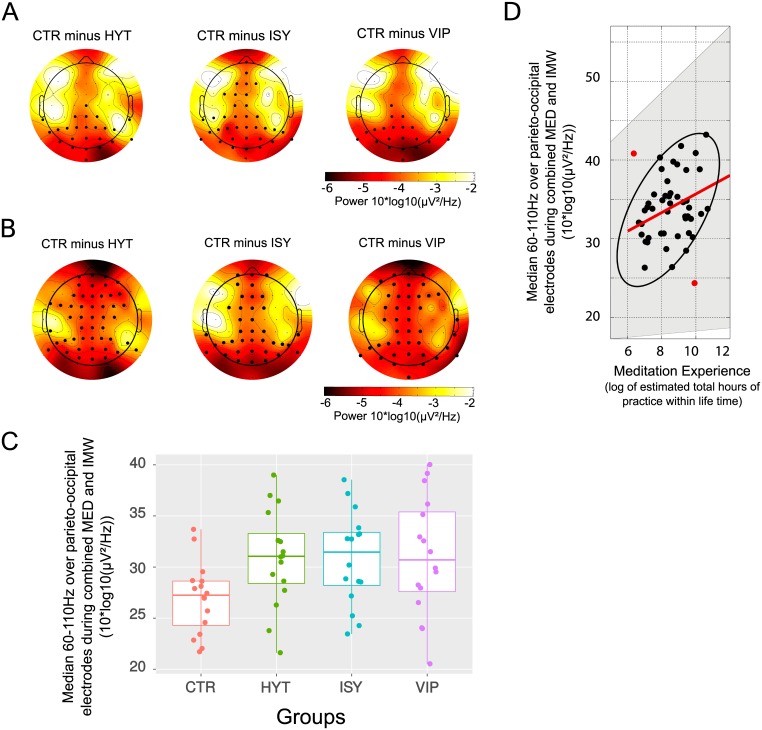
A. Spectral differences in the 60–110 Hz range between the control group and each of the meditator groups with MED and IMW conditions combined. A black dot at a given electrode site indicates significance at p<0.05 corrected for multiple comparisons (see Method). B. Spectral differences in the 60–110 Hz range between the Control group and each of the meditator groups during MED condition only. A black dot at a given electrode site indicates significance at p<0.05 corrected for multiple comparisons (see Method). C. Distribution of individual median 60–110 Hz activity over parieto-occipital electrode for combined meditation and IMW conditions in each group. D Median gamma power over parieto-occipital electrodes for the combined meditation and instructed mind-wandering conditions in the three meditator groups, as a function of log-scaled estimated hours of lifelong meditation practice (skipped Pearson’s r = 0.33, confidence interval (CI) = [0.06 0.53]). The grey shaded area shows the 95% bootstrapped CIs. A red dot denotes an outlier that was left out from the computation of the robust correlation analysis whereas the ellipse surrounds the data points included in it.